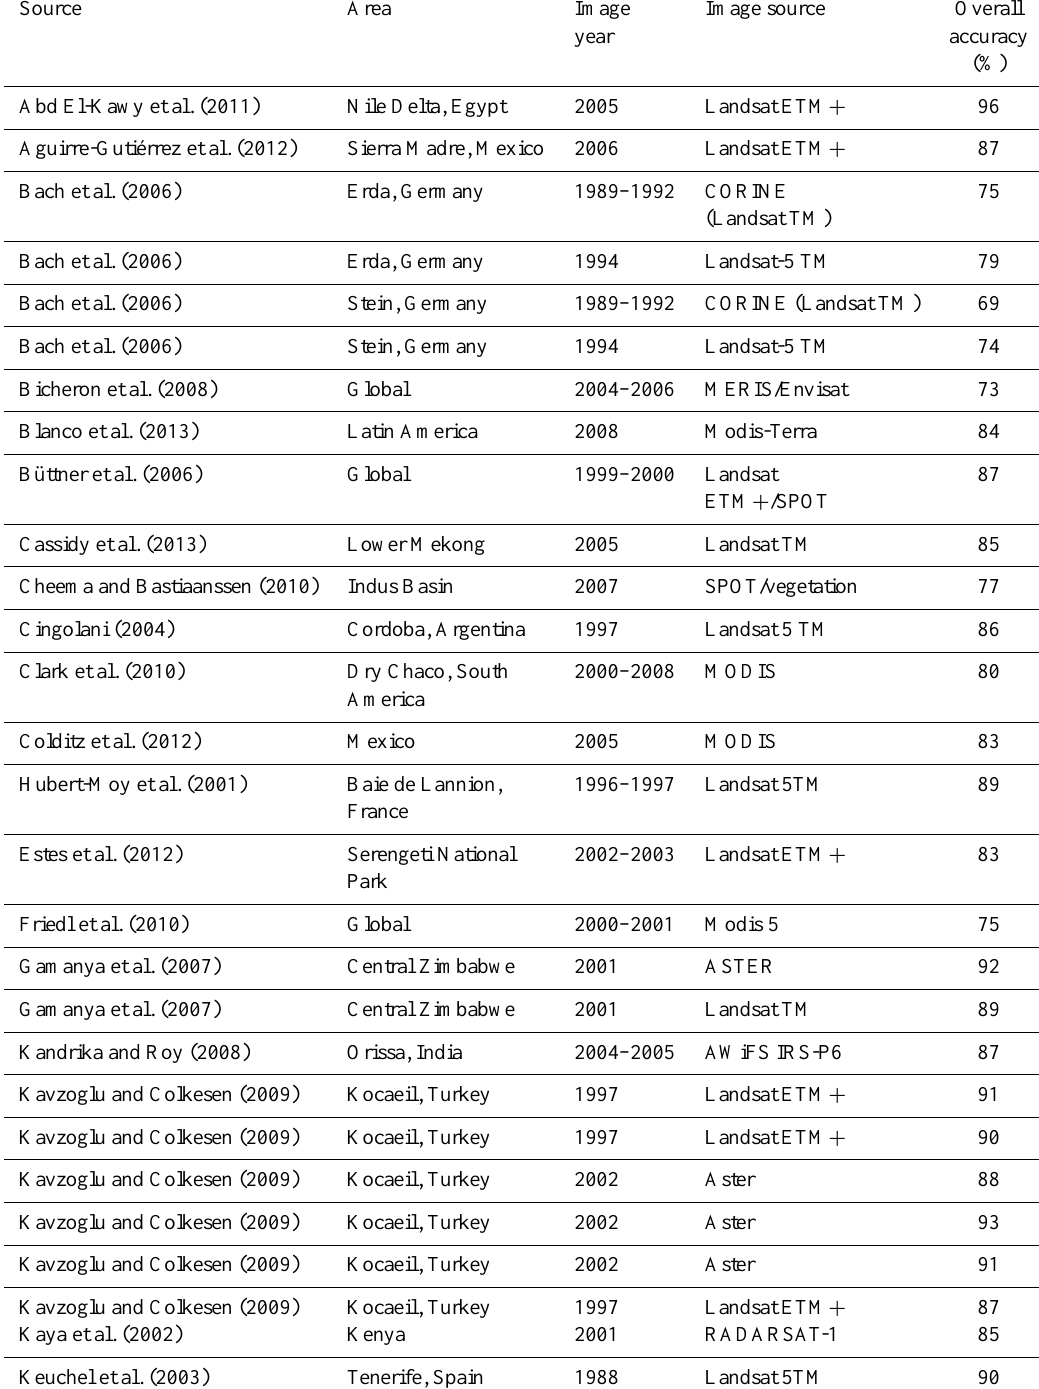
Table C1. Selected validation papers that report on confusion